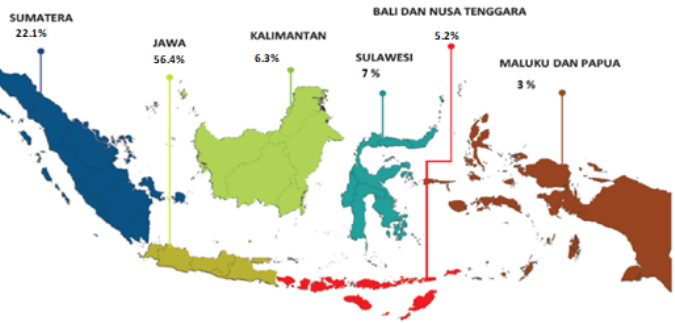
Figure 3. Contribution of internet users by region from all users [36] .